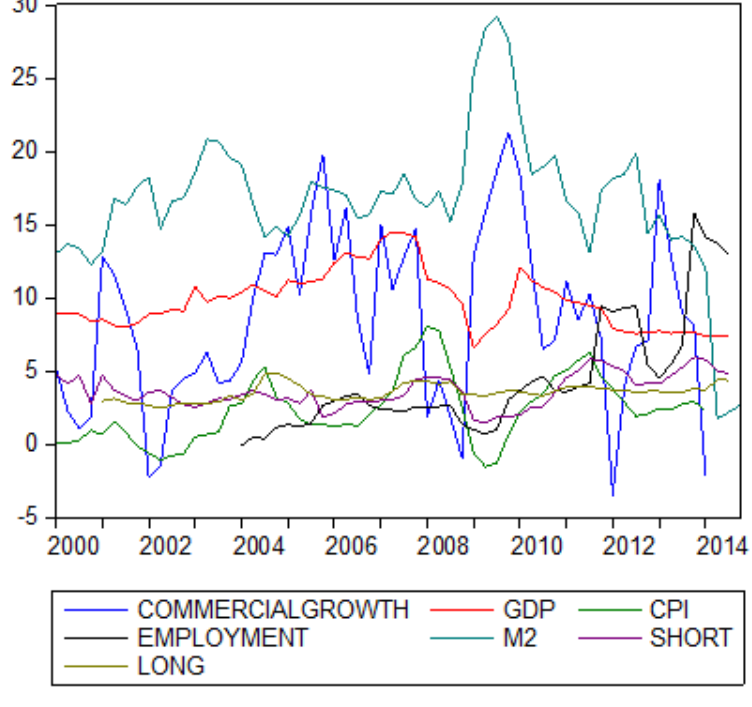
Figure 2. Real Estate Price and Macroeconomic